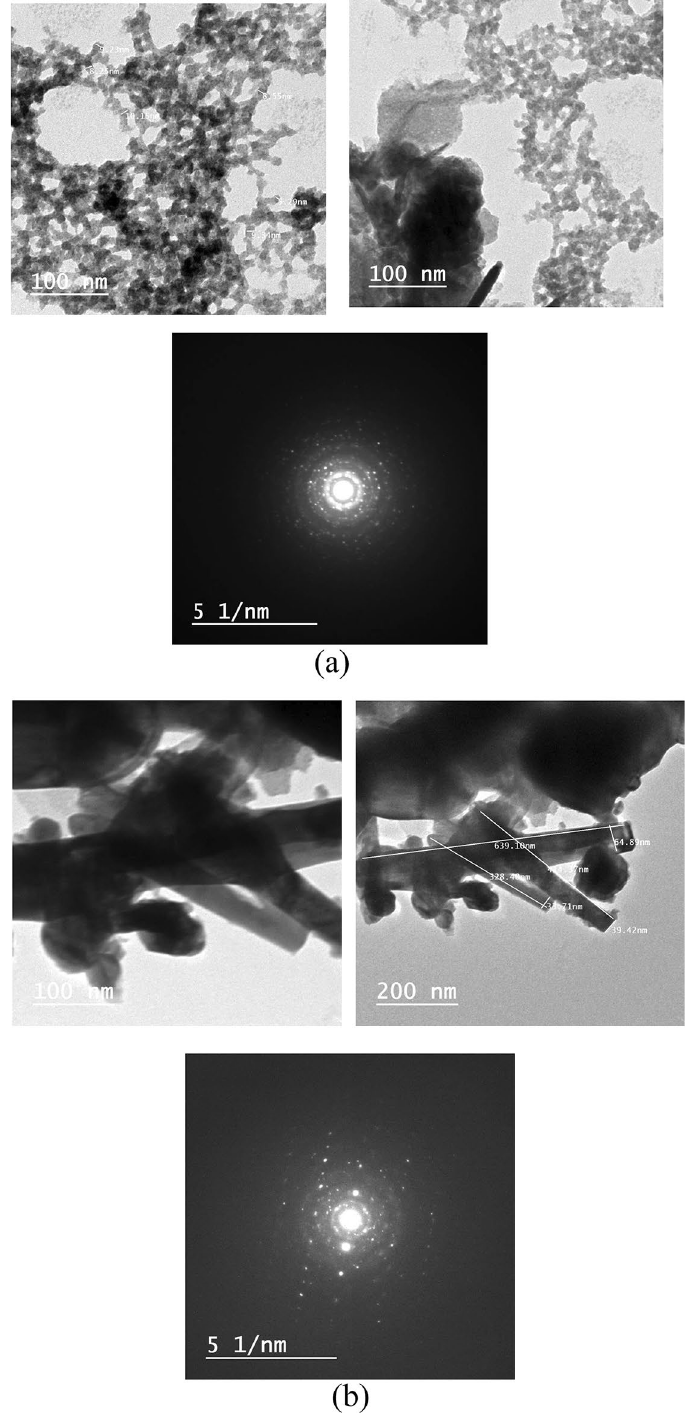
Figure 4. ( a ) TEM of Er-doped PEZ of thin film sample. ( b ) TEM of Er-doped PEZ nano-rods of bulk